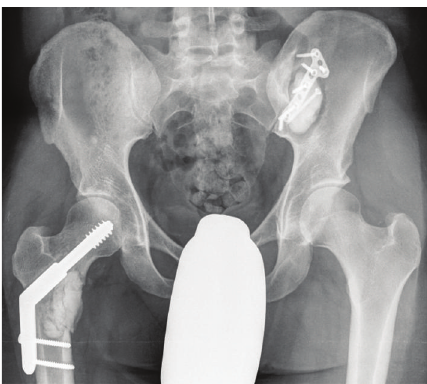
Figure 6: Conventional radiography of the pelvis (AP view): after curettage of the lesions at the right proximal femur and of the left iliac wing, the defects were filled with bone cement; prophylactic stabilizations using a dynamic hip screw at the right side and a plate at the left posterior iliac crest were performed.